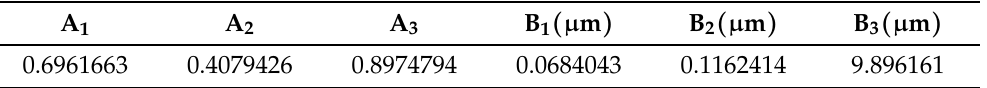
Table 1. The related parameters of the Sellmeier equation for the silica material.